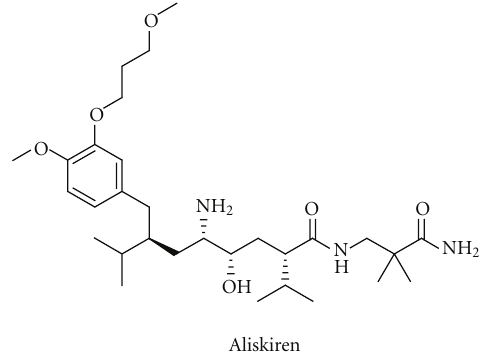
Figure 3: The structure of the renin inhibitor